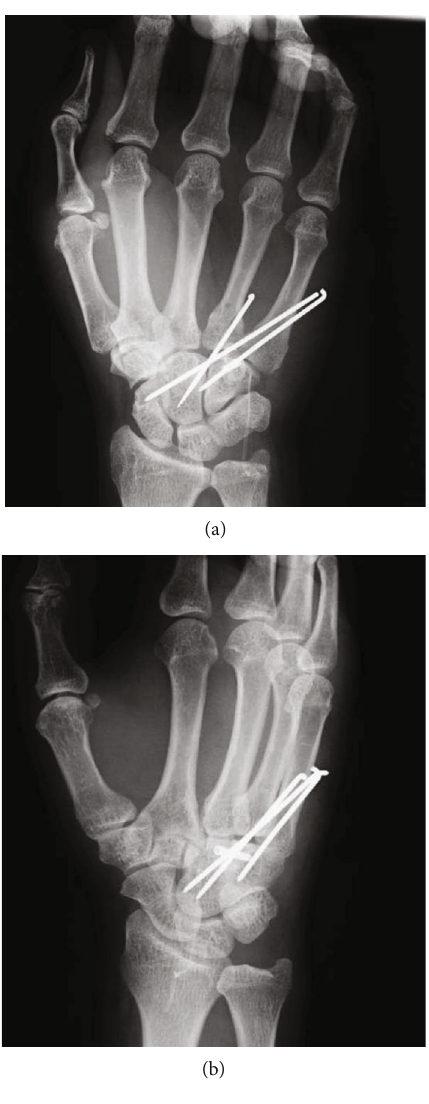
Figure 5: Postoperative radiograph. (a) Posteroanterior view. (b) Oblique semisupinated view.